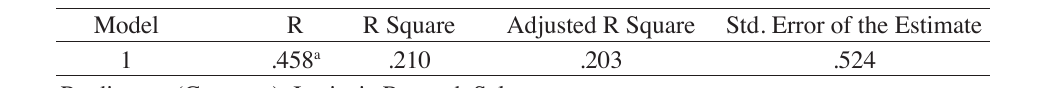
Impact of Reward on Job Satisfaction